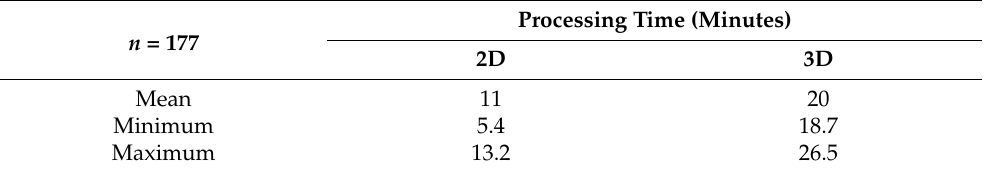
Table 3. Processing times of the 2D- and 3D-based measurement methods of orbital floor defect areas.